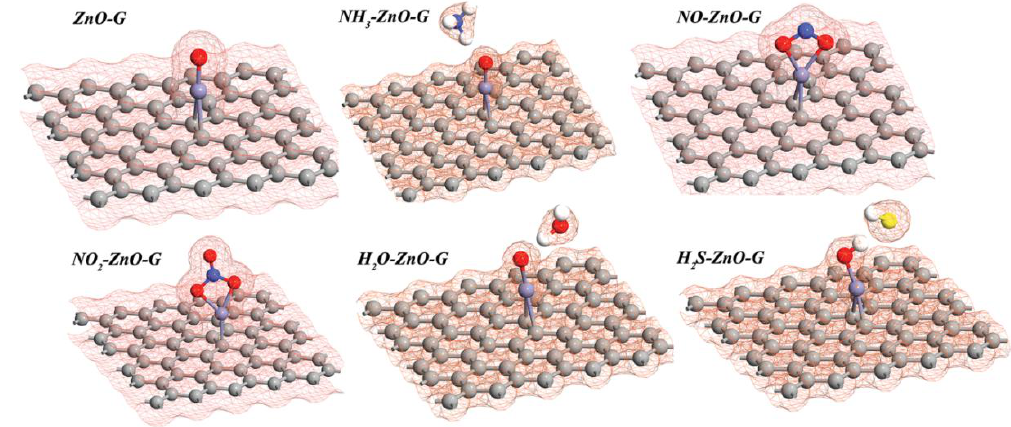
Figure 4. The electronic total charge densities of the ZnO–graphene sensor before and after complexation with NH 3 , NO, NO 2 , H 2 O, and H 2 S. The gray, purple, red, blue, yellow, and white balls represent C, Zn, O, N, S, and H atoms, respectively.